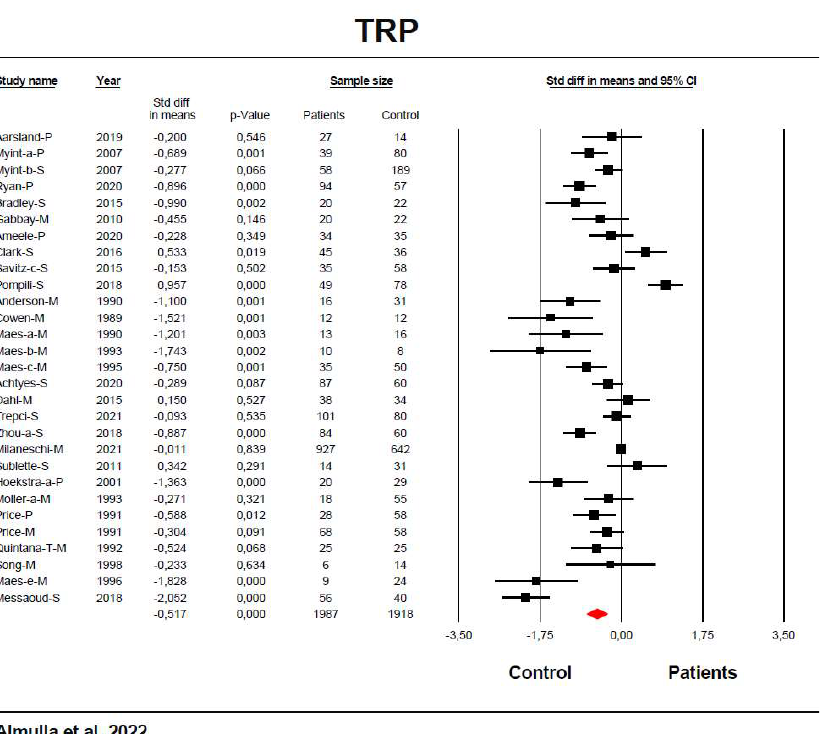
Figure 3. The forest plot of tryptophan (TRP) between severe affective disorder patients and healthy control.